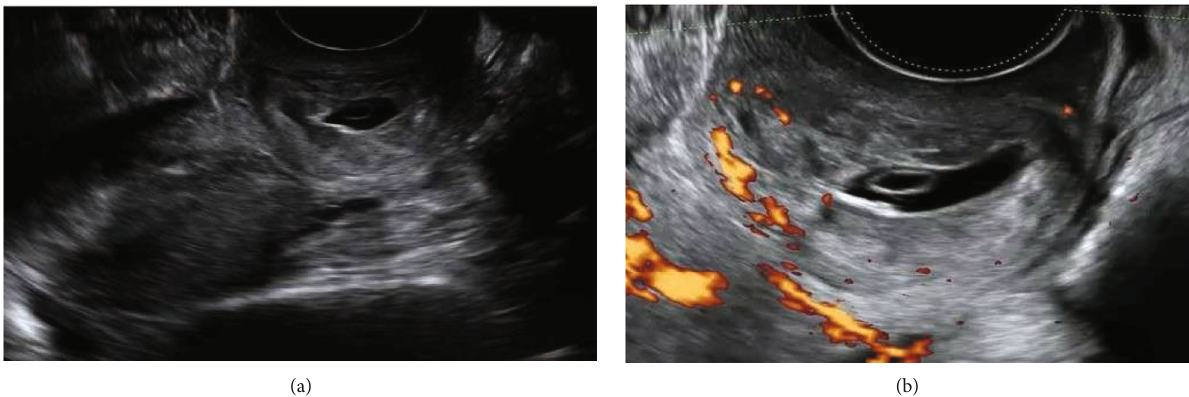
Figure 1: Cervical pregnancy at presentation (a) 2D transvaginal sonography in sagittal view shows an empty uterine cavity and closed internal os with ballooned cervical canal containing gestational tissue with (b) evidence of peritrophoblastic vascularity.